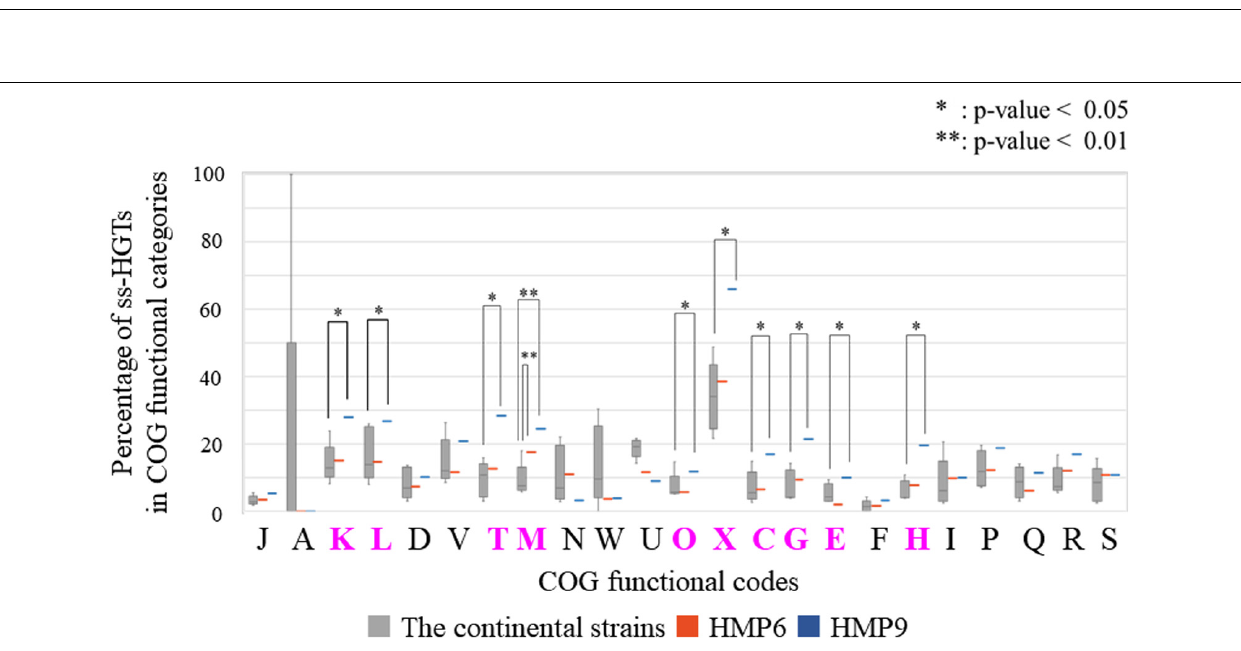
Frontiers in Microbiology |